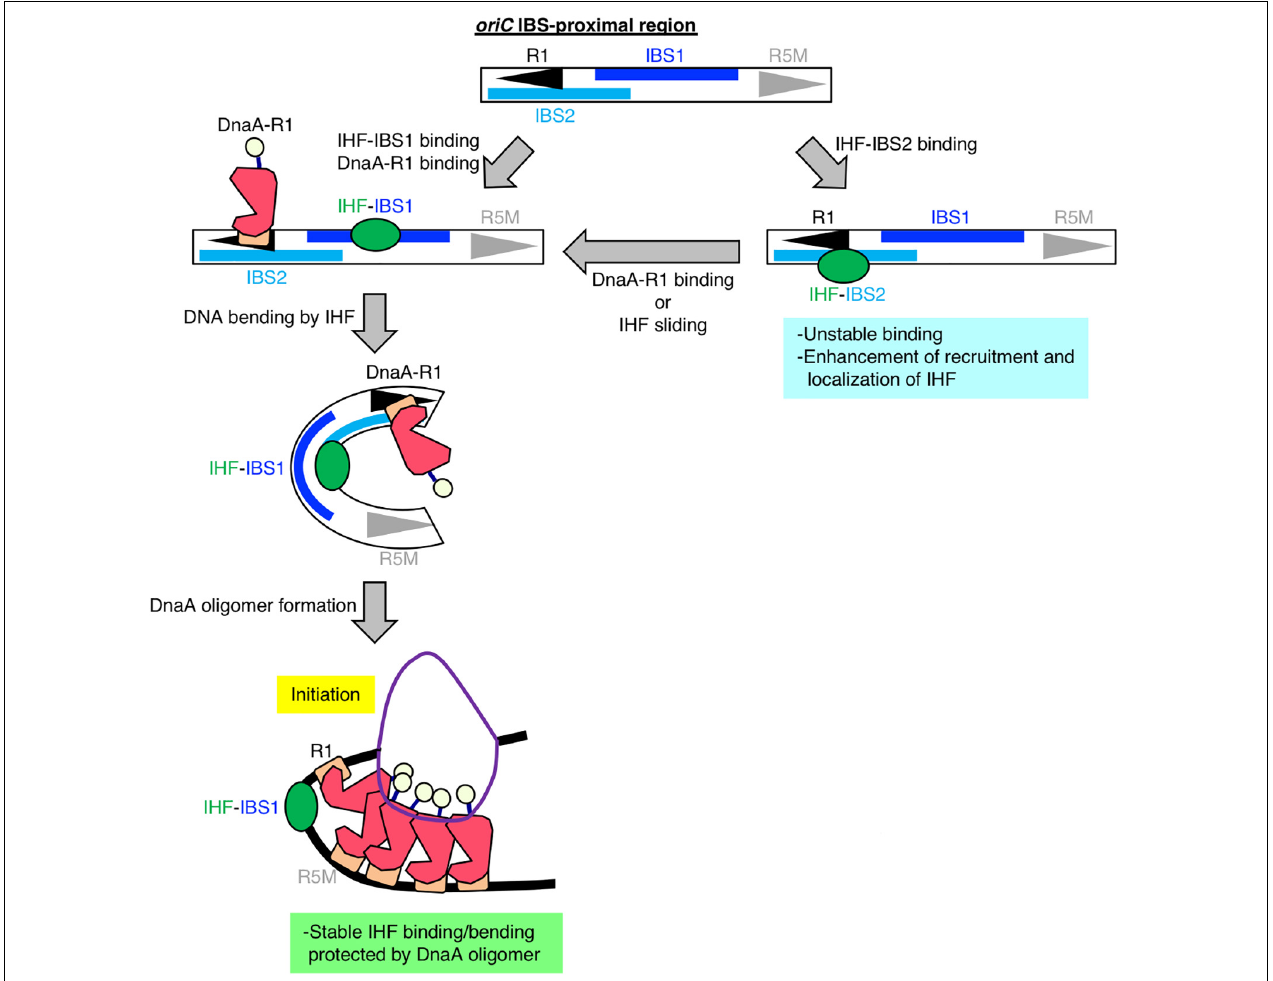
FIGURE 6 | Model of DnaA box R1-mediated stabilization of IHF binding at oriC . Our findings suggest that, specifically at the stage of replication initiation, a secondary IBS (termed IBS2 in this study; sky-blue bar) overlaps with DnaA box R1, providing a new possible role for DnaA box R1 (black arrowhead). First, IHF binds to either a known IBS (IBS1; blue bar) or IBS2. When IHF binds to IBS2, DnaA cannot bind to R1; thus we hypothesize that even though oriC IBS2–IHF binding is relatively unstable, it plays a supportive role in stabilizing overall IHF binding at oriC by preventing free diffusion of IHF dissociated from oriC and promoting re-binding to oriC . When IHF binds to IBS1 with higher affinity and bends DNA, ATP–DnaA can form higher-order oligomers to initiate replication from oriC . In the initiation complex, IHF binding and bending at IBS1 is further stabilized by an ATP–DnaA oligomer, which is formed by interaction between ATP–DnaA molecules bound at R1 and another DnaA box R5 (gray